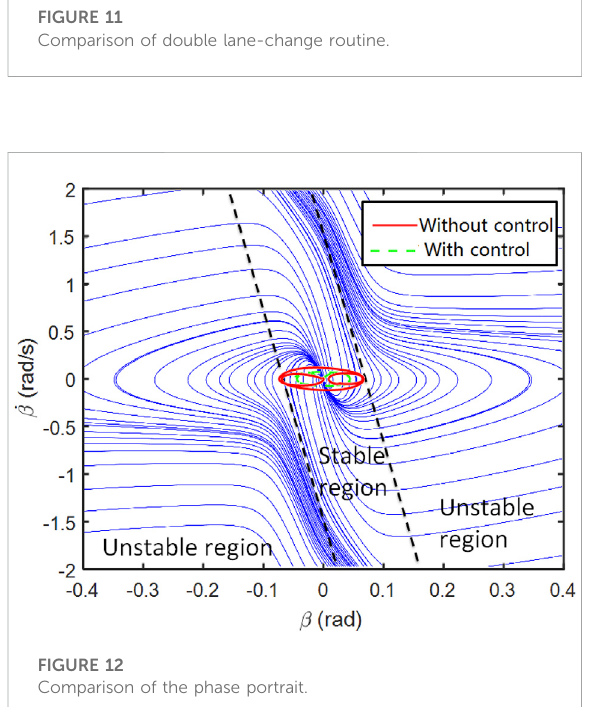
FIGURE 12 Comparison of the phase portrait.